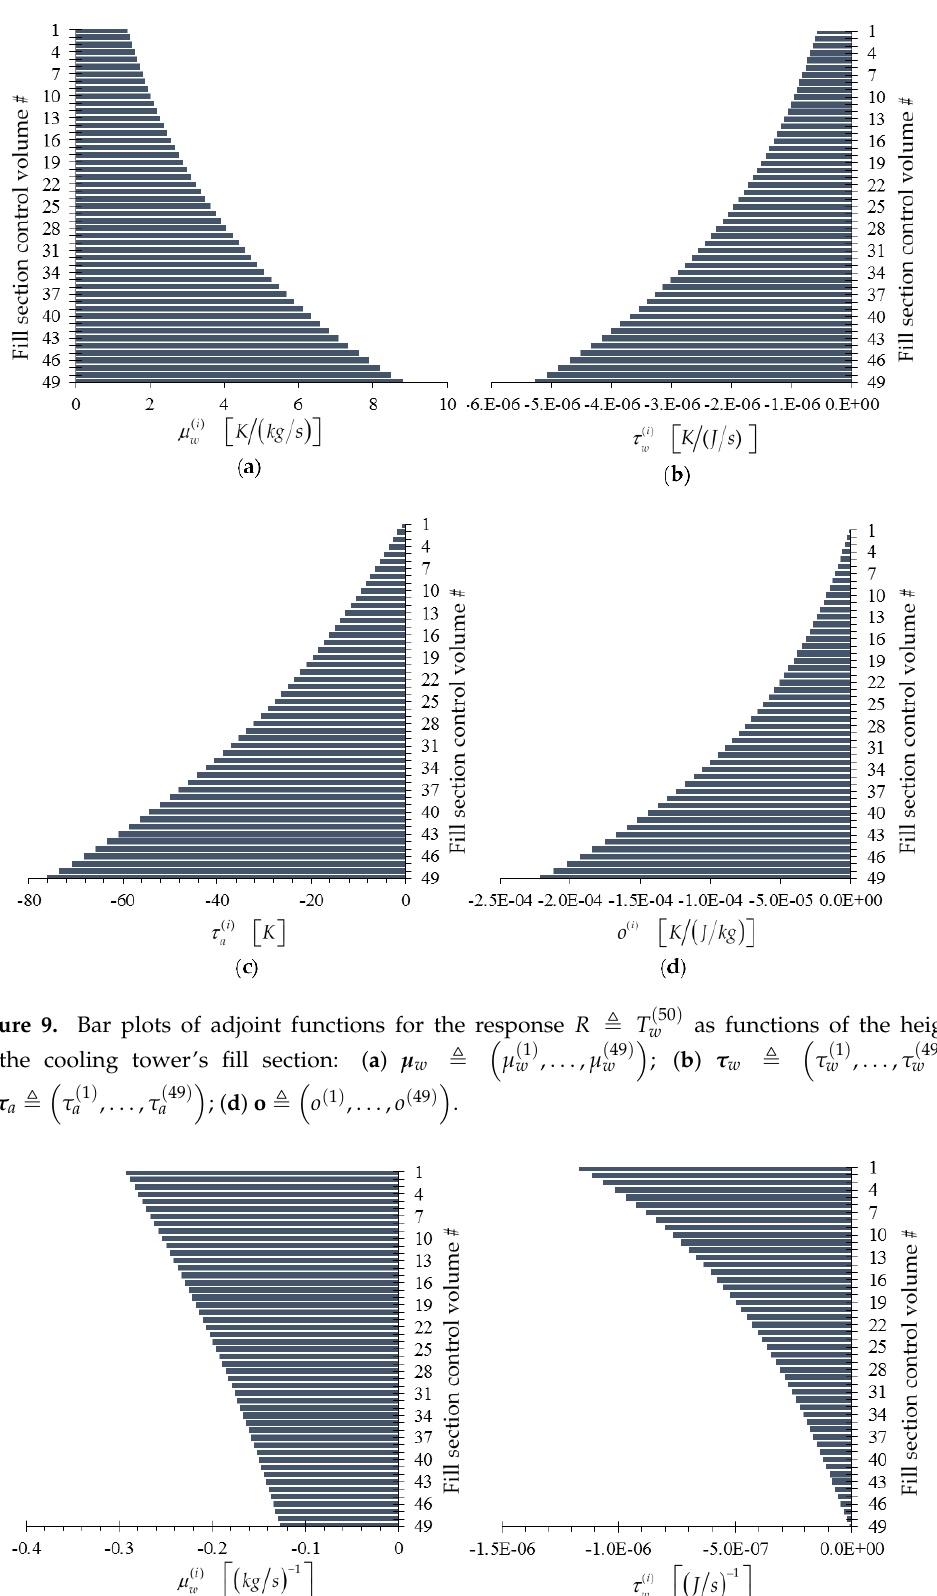
(cid:16) (cid:17) ( 1 ) ( 49 ) τ ; w , . . . , τ w